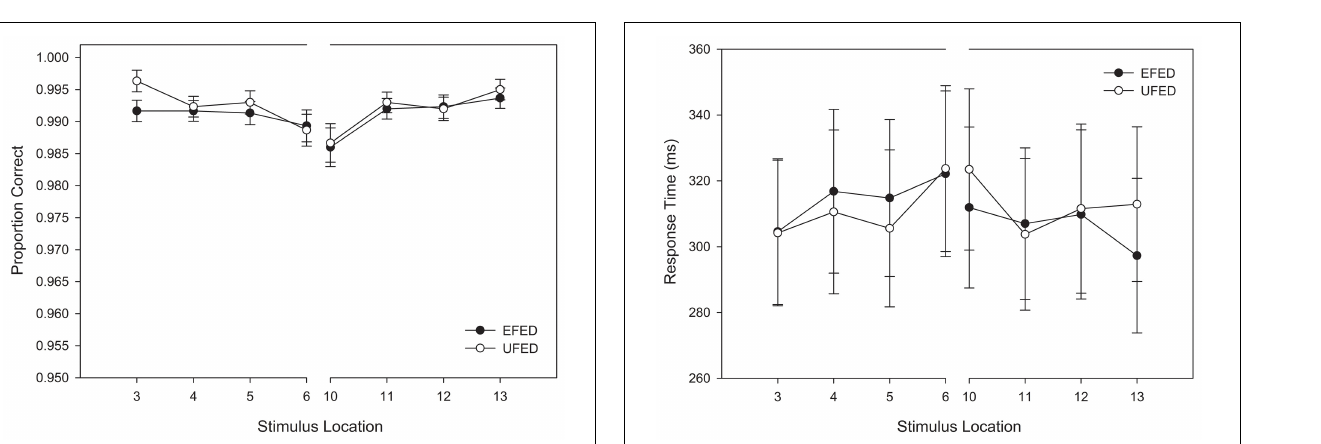
FIGURE 4 | Training categorization response accuracy in equal frequency (EFED) and unequal frequency conditions (UFED). Stimulus values correspond to stimuli selected from the training range (i.e., stimuli 3–13). Error bars represent 1 standard error of the mean ( N = 60).